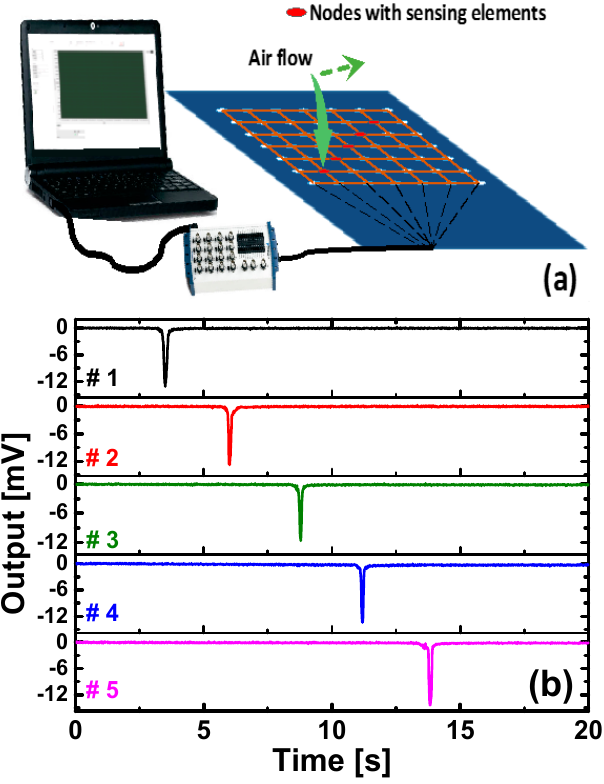
Figure 9. ( a ) Measurement setup of the stretchable pressure network prototype; ( b ) Network response from five nodes to a moving compressed air gun.